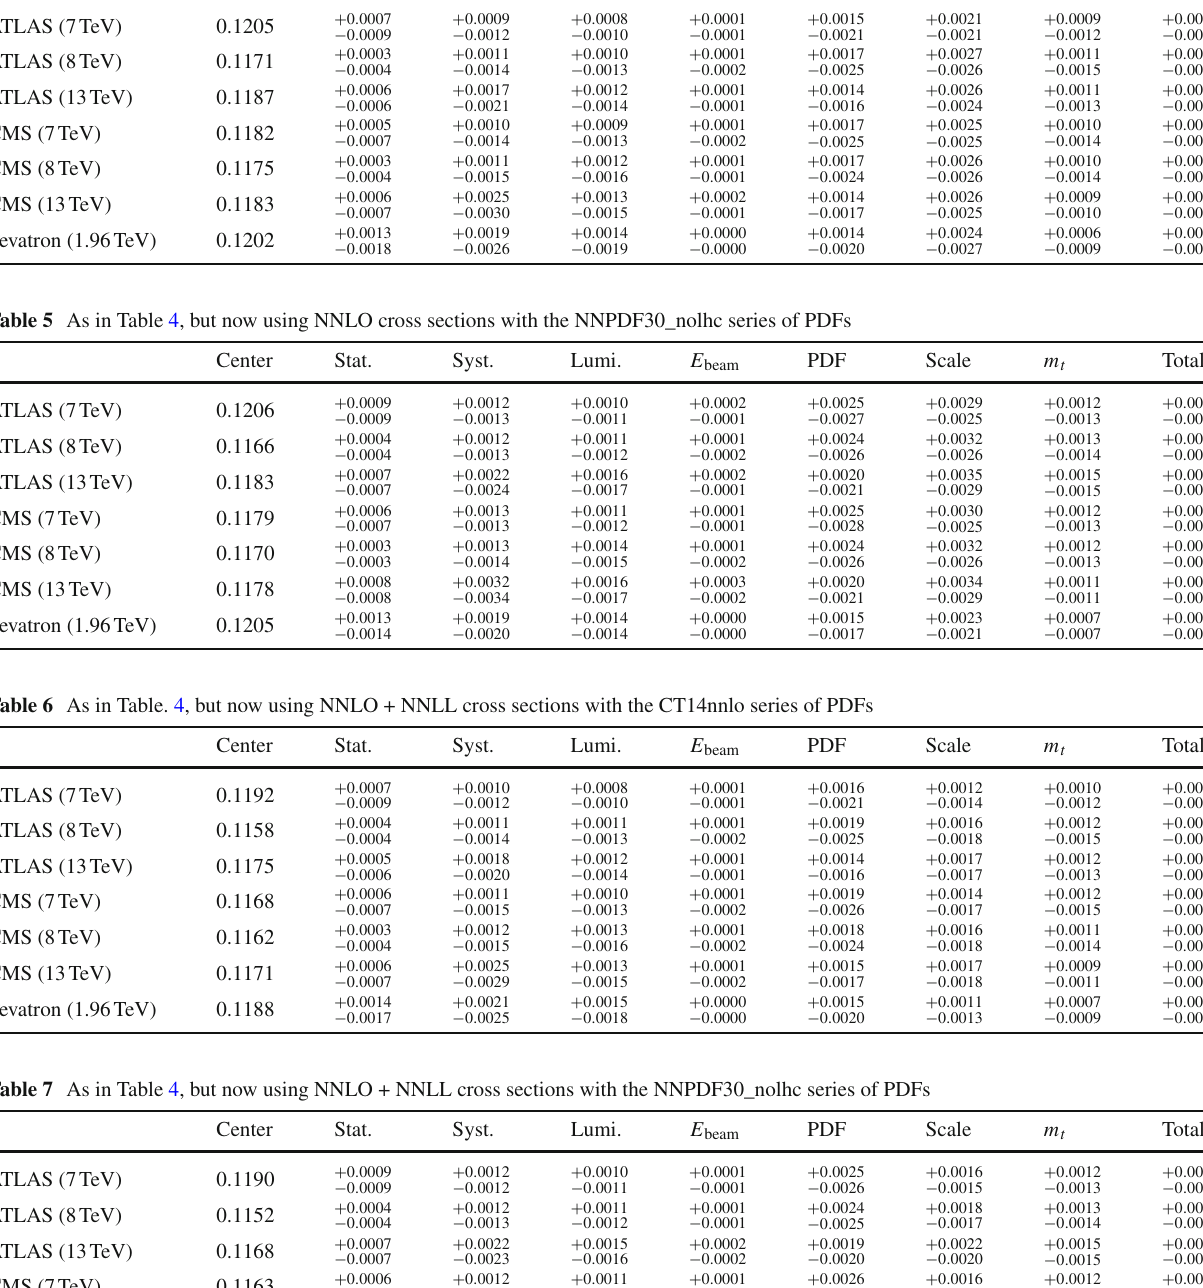
Table 4 Results for the strong coupling evaluated at the Z-boson mass scale and individual uncertainty contributions. These are based on cross sections calculated at NNLO using the CT14nnlo series of PDFs Center